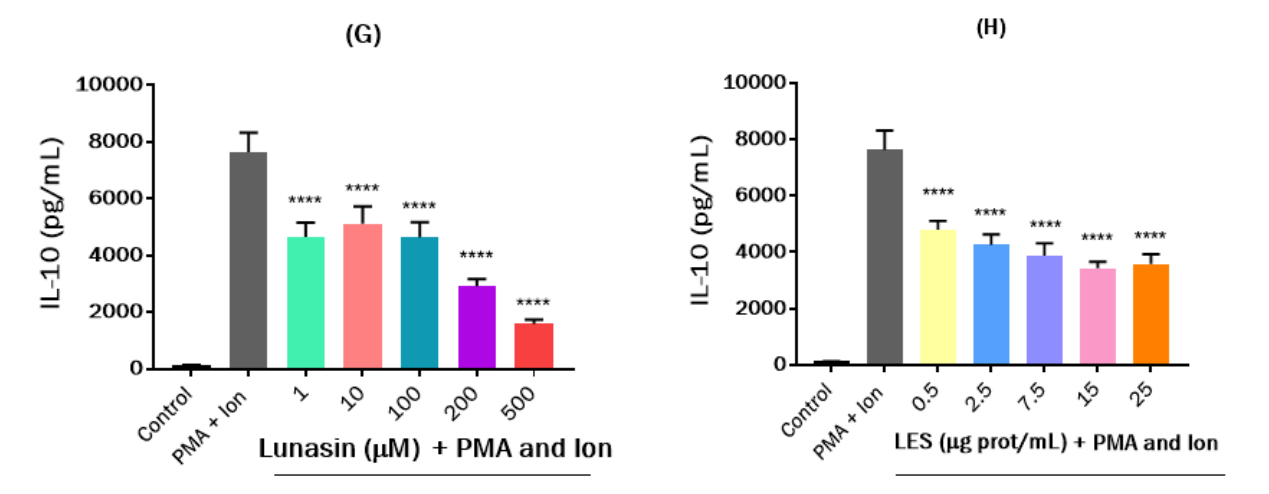
Figure 5. Effects of synthetic lunasin and lunasin-enriched soybean extract (LES) on cytokine release by stimulated EL-4 cells. Effects on the release of ( A , B ) IL-4, ( C , D ) IL-5, ( E , F ) IL-2, and ( G , H ) Il-10 of ( A , C , E , G ) synthetic lunasin (1–500 µM) and ( B , D , F , H ) LES (0.5–15 µg protein/mL) by EL-4 cells induced by phorbol 12-myristate 13-acetate (PMA, 10 ng/mL) and Ionomycine (Ion, 100 ng/mL) after 24 h of treatment. Significant differences compared to PMA + Ion-induced cells: * p < 0.05; ** p < 0.01; *** p < 0.001; **** p < 0.0001.